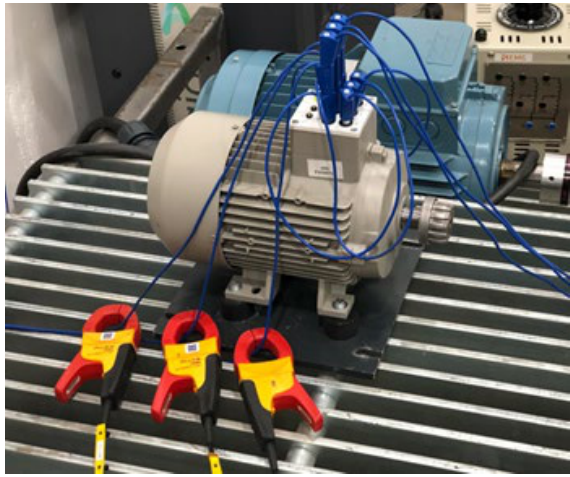
Figure 2. Experimental setup for data collection.